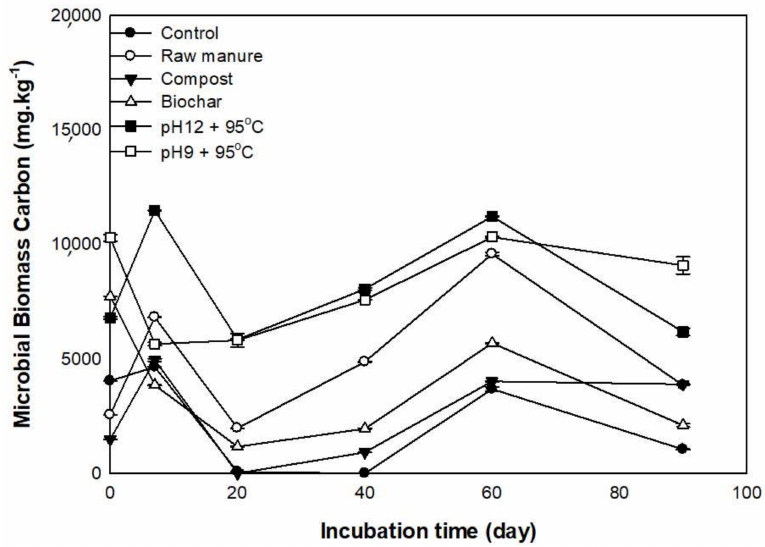
Figure 10. Effect ofdifferent organic amendments derived from cow manure and incubation time on soil microbial biomass carbon extracted with potassium